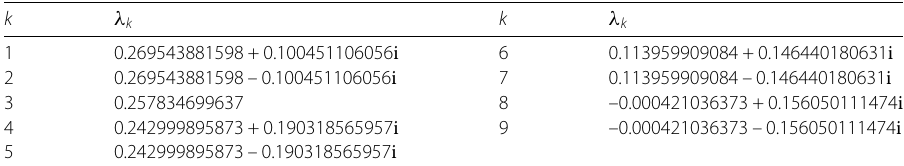
Table 8 The eigenvalues λ k of U n , n = 9, for the weight function of Example 10 k λ k k λ